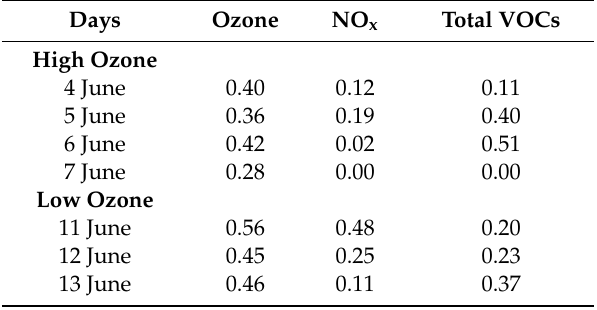
Table 6. The correlation coe ffi cient (R) between the modeled PBLH (using HYSPLIT) and ozone concentrations and its precursors during the high and low ozone